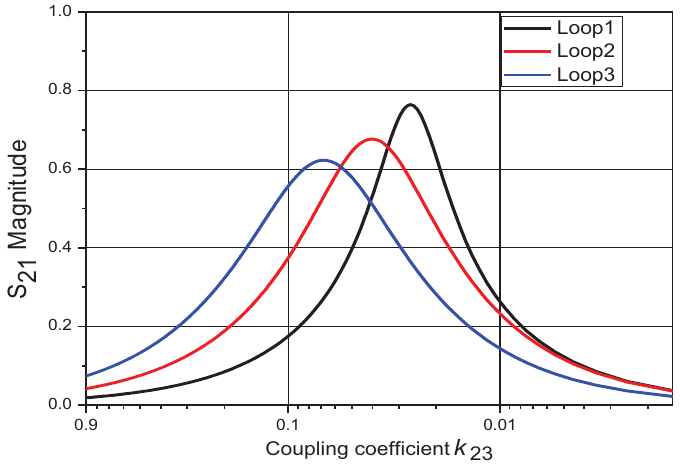
Figure 6. Simulated S 21 magnitude for different loops with varying k 23 in the Case 1